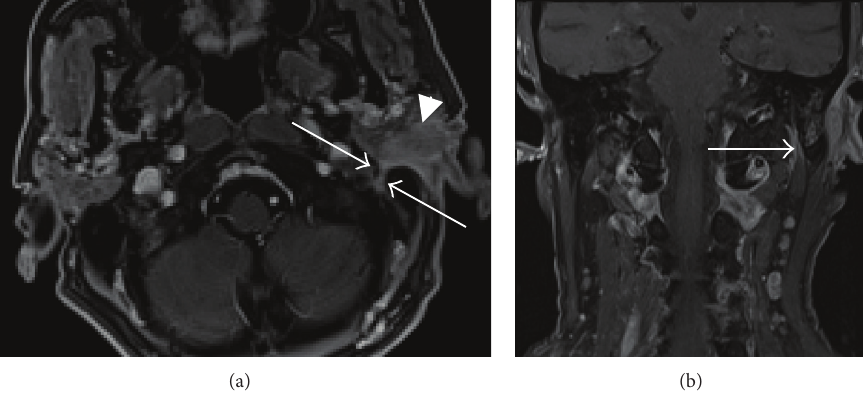
Figure 9: Perineural tumor spread along CN VII. Axial T1 (a) and coronal (b) postcontrast fat-saturated images demonstrate an enlarged, enhancing left facial nerve in the stylomastoid foramen and mastoid segment of the facial nerve canal (arrows), indicating perineural tumor spread from invasive squamous cell carcinoma (arrowhead) of the left external auditory canal.